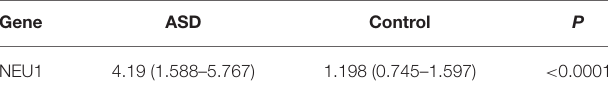
TABLE 3 | NEU1 mRNA expression between groups ( p -values) [M (Q1 ∼ Q3)].